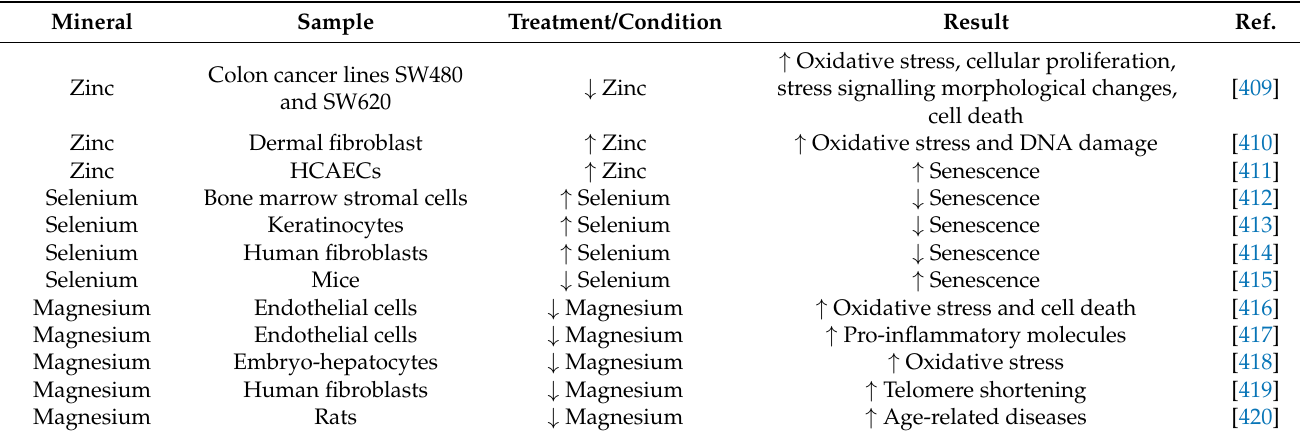
Table 5. Minerals as modulators of OS-induced